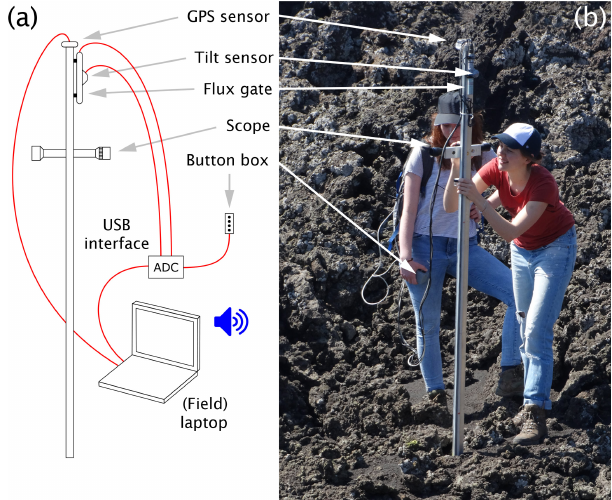
Figure 1. The AnomalyMapper. The AnomalyMapper consists of a GPS sensor, a tilt sensor, a fluxgate sensor, and a scope mounted on an aluminum frame, and it is operated by pressing buttons on a but- ton box (a) . The electronic components are connected (red lines) to a ruggedized laptop through USB interfaces, and the laptop has au- dible feedback to the users. The AnomalyMapper is easily operated by two people in the field (b) , while the USB interface and laptop are carried in a small